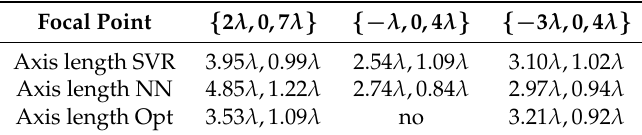
Figure 1. Example #1. Normalized near-field power density at y = 0 for the support vector regression (SVR) method ( a ), the neural network in [14] ( b ) and the optimization in [13] using a non-coupling model ( c ). The symbols + and ◦ represent the focal and synthesized maximum points respectively. Table 1. Example #1. Axis length (major, minor) using SVR, neural networks (NN) and optimization